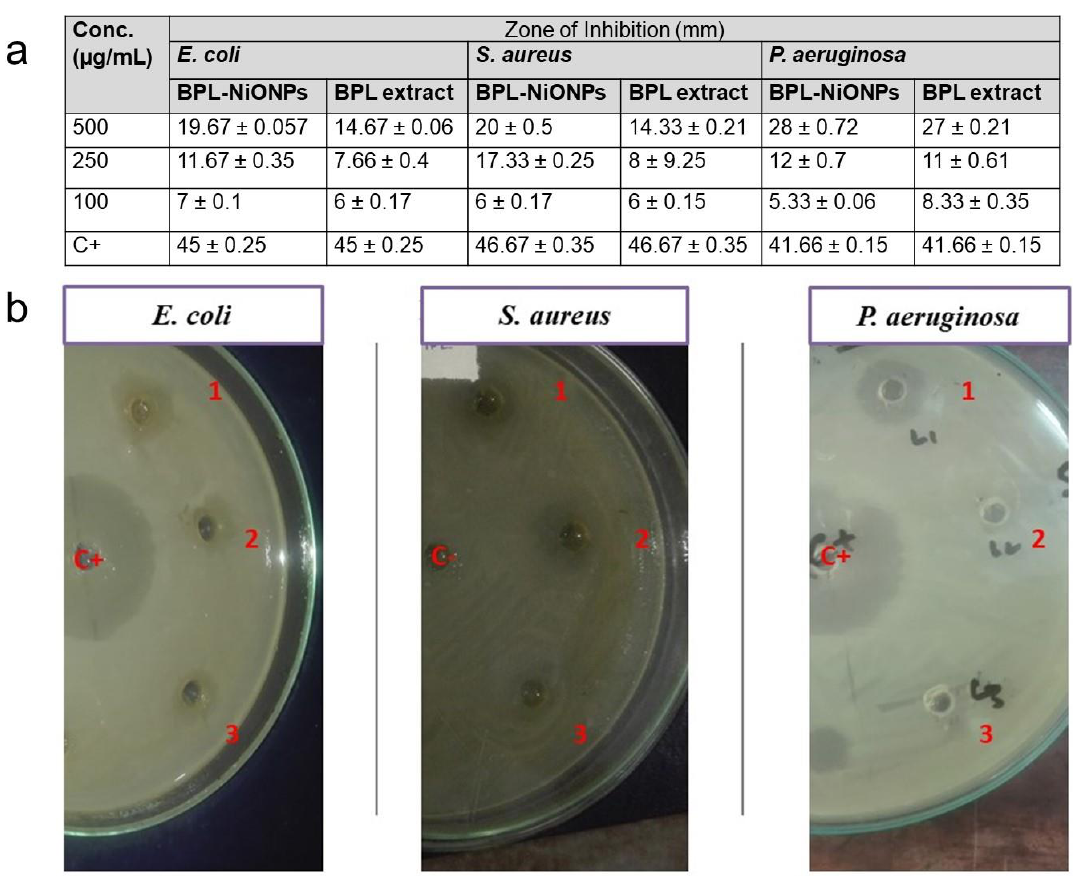
Figure 4. Antioxidant activity of BPL and BPL-NiONPs: ( a ) DPPH analysis; ( b ) TAC analysis. Obtained data are presented as mean ± standard deviation ( n = 3).